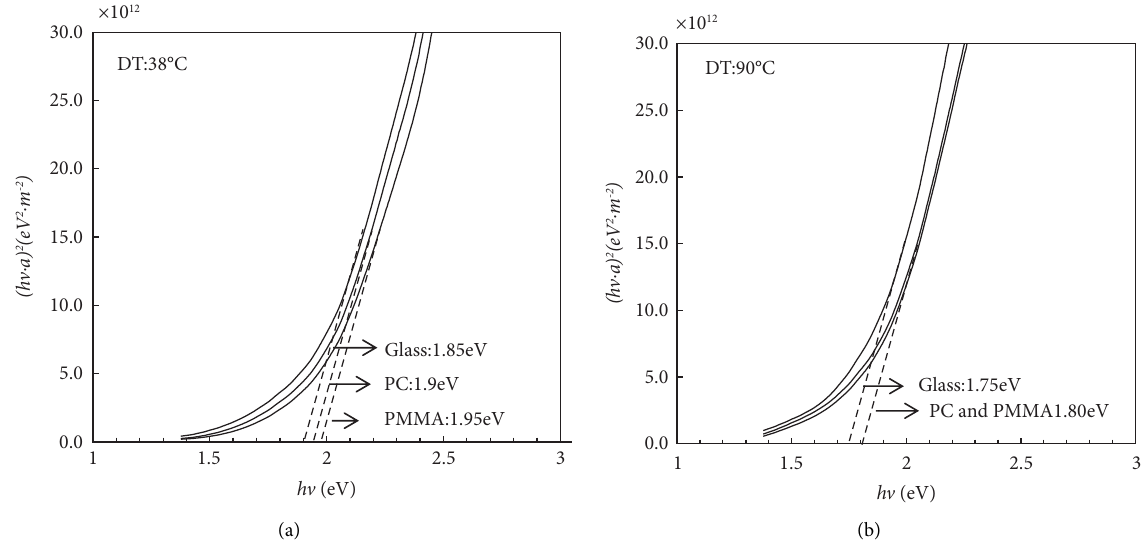
Figure 6: Bandgap of samples (a, b) that formed at 10W on PMMA, PC, and glass substrates.